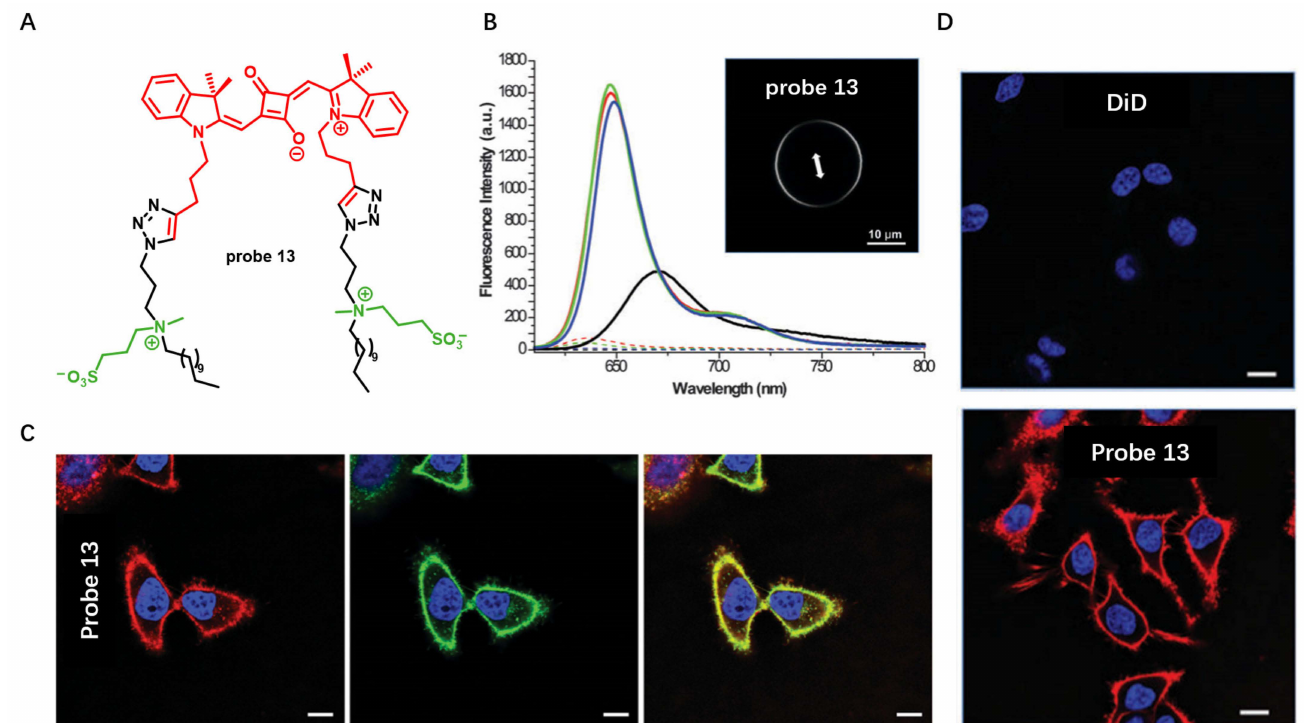
Figure 13. ( A ) Chemical structure of probe 13 . ( B ) Fluorescence spectra of probe 13 in buffer solu- tions and in the presence of lipid membranes. ( C ) Confocal images of CM stained with 1 nM probe 13 without washing. Scale bar: 10 µ m. ( D ) CM staining with DiD and probe 13 at 20 nM. Scale bar: 10 µ m. Copyright 2015 Royal Society of Chemistry